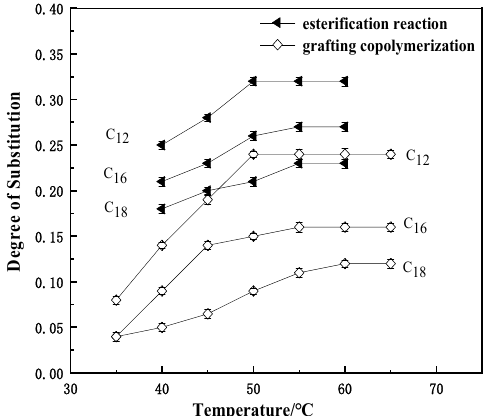
Figure 4. Effect of reaction temperature on substitution degree of MCNC.